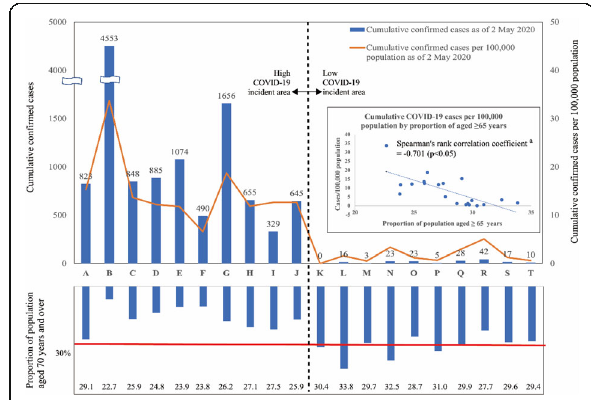
Fig. 1 Cumulative COVID-19 cases, cases per 100,000 population and proportion of population aged ≥ 65 years. a Due to non-normal distribution of data, Spearman ’ s rank correlation test was